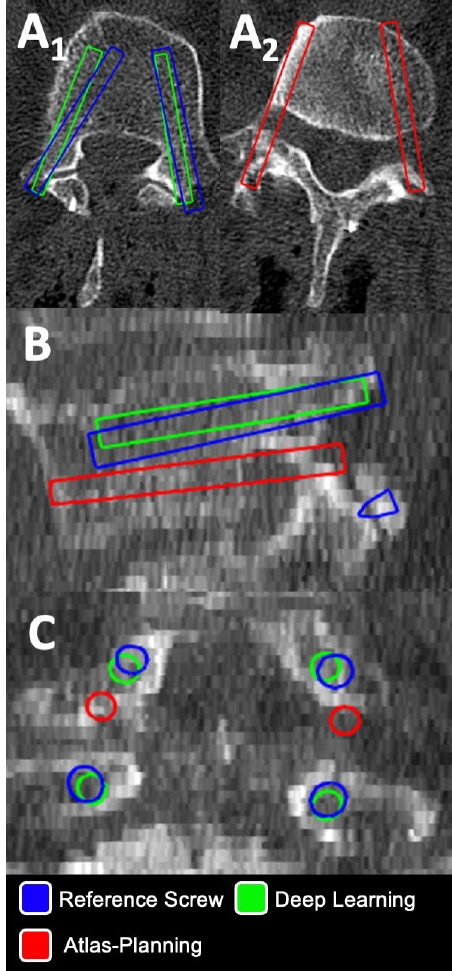
Figure 5. Illustration of screw evaluation in a L4 + L5 instrumentation after previous L5 laminectomy in axial ( A 1 , A 2 ), sagittal ( B ) and coronal ( C ) planes. Note the significant pedicle breach in atlas-based planning at L4 ( A 2 , B , C ). Deviations of screw head and tip points and angular deviation were automatically calculated in Python for deep-learning-(green outline) and atlas-based screws (red outline) vs. corresponding reference screws (blue outline), respectively.